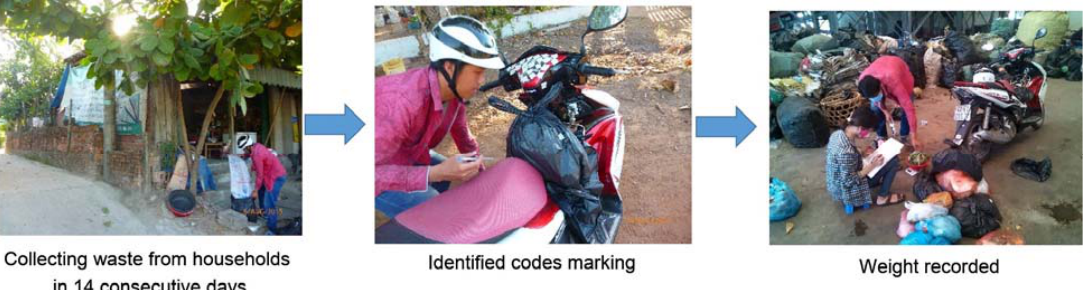
Fig. 1: Waste sample collection procedures